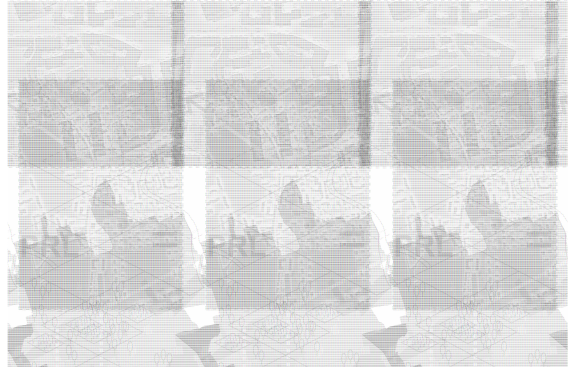
Figure 2. Some Resources Geographies that make up the local renewable potential, solar energy maps and biomass availability